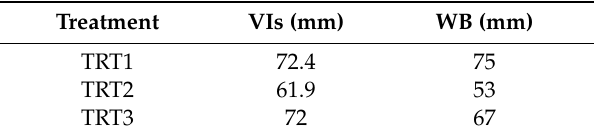
Table 5. Cumulative ET from the 6–29 August 2017 investigative period calculated by the VI (vegetation index) method and water balance approach for the three irrigation